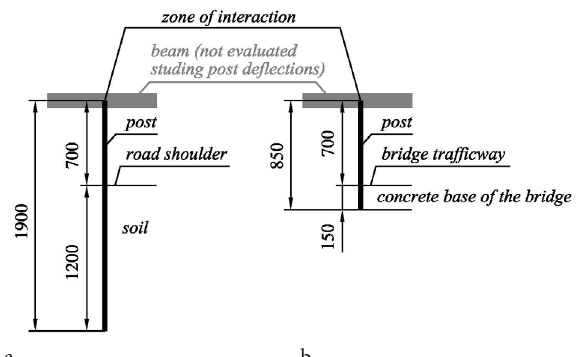
Fig. 3. A schematic view of the metal guardrail post mounted